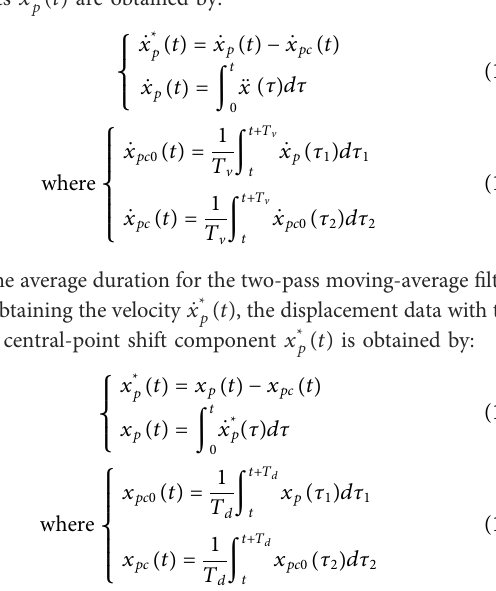
Figure 4B clari fi es the relationship between the average durations and frequency components to be minimised, showing some unwanted humps in the curve. This indicates that the